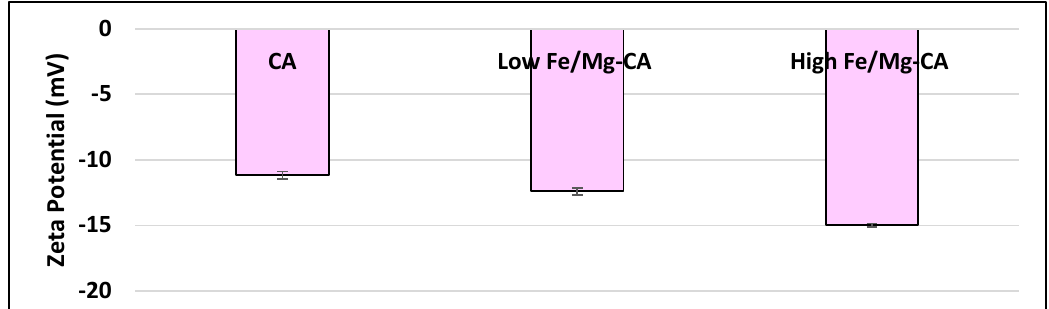
Figure 3. Surface charge measurement of CA, low Fe/Mg-CA and high Fe/Mg-CA NPs. The particles were generated through incubation at 37 °C for 30 min after exogenously adding to 1 ml of DMEM a fixed concentration of Ca 2+ (4 mM Ca 2+ ) for CA NPs and additionally, two different concentrations of Fe 3+ , 1 µM and 5 µM and Mg 2+ , 4 mM and 12 mM, respectively, for low Fe/Mg-CA and high Fe/Mg- CA NPs .